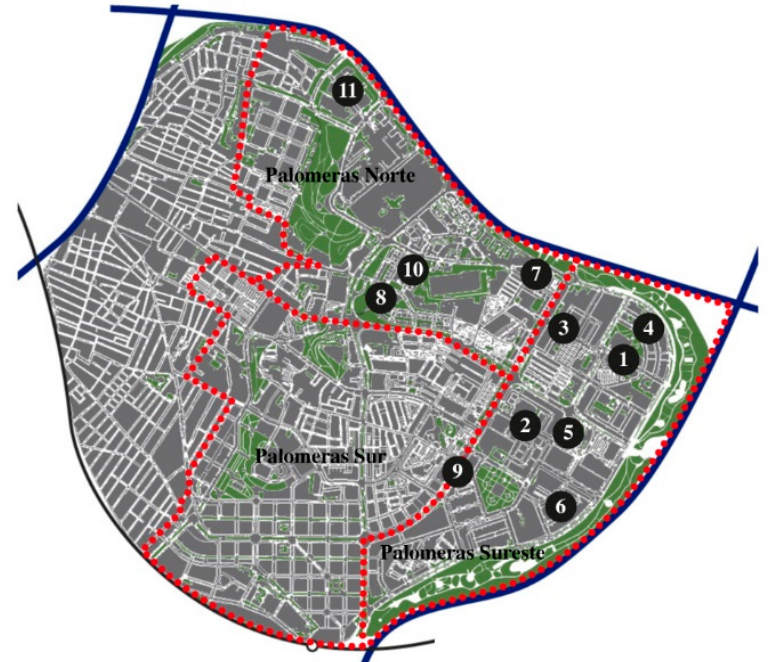
Figure 2. Palomeras plan with original sectors; Location of housing projects studied. Created by author.